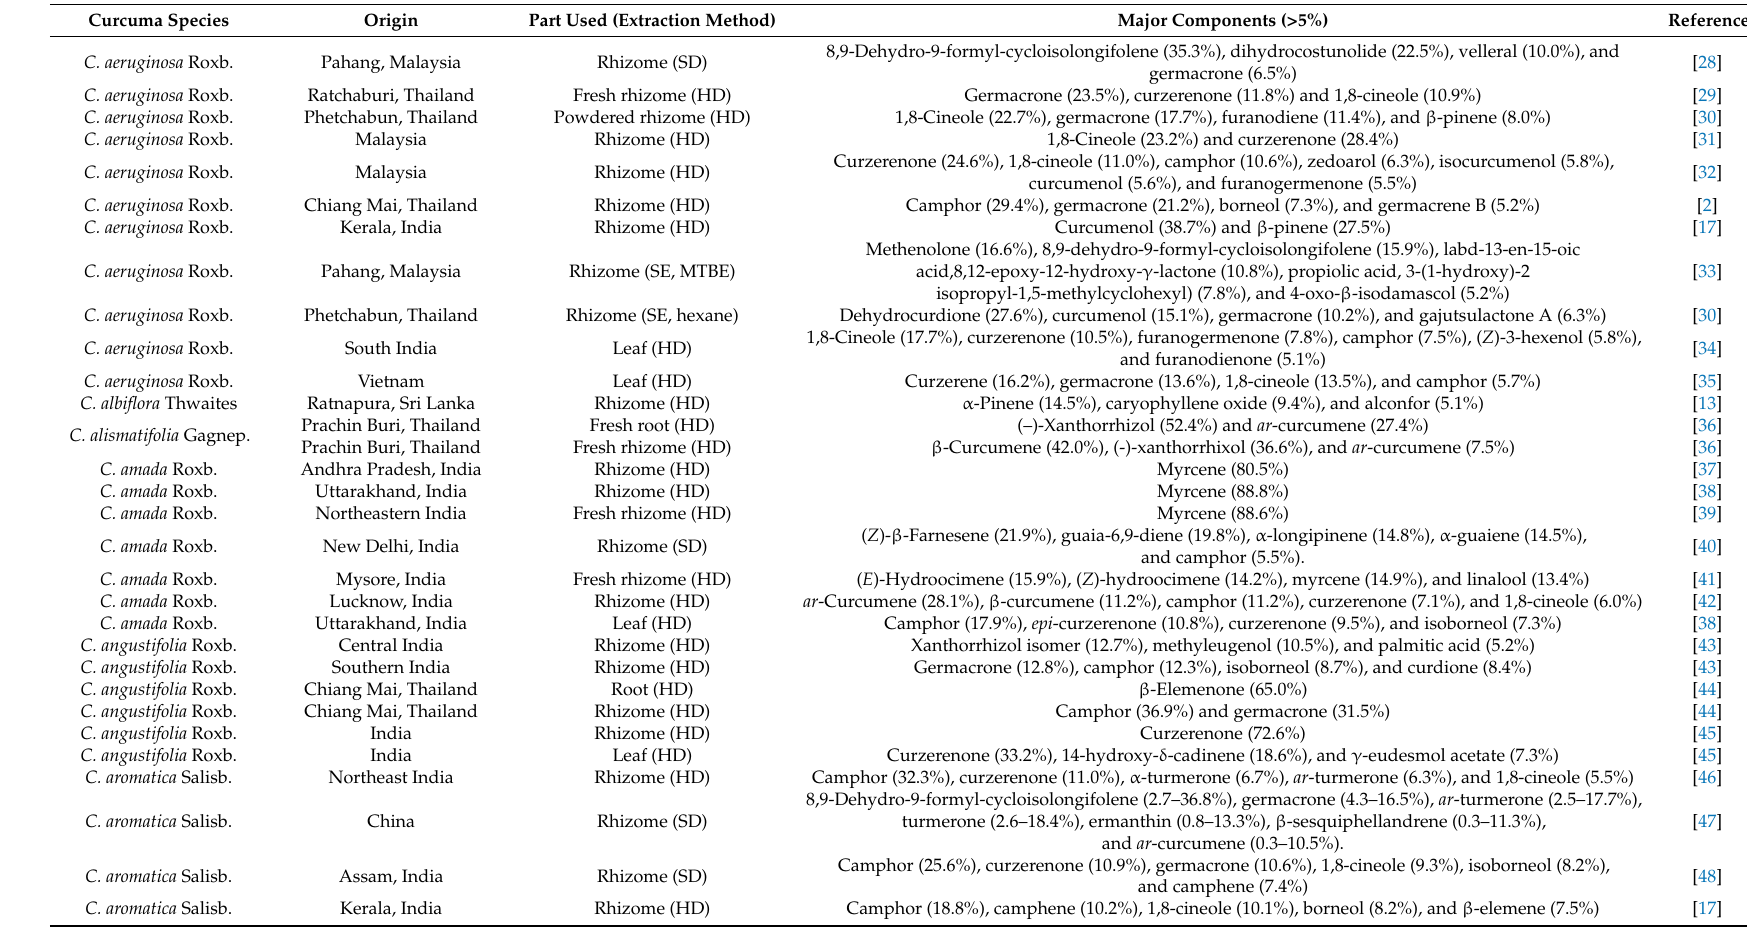
Table 1. Major volatile components (>5%) in different Curcuma